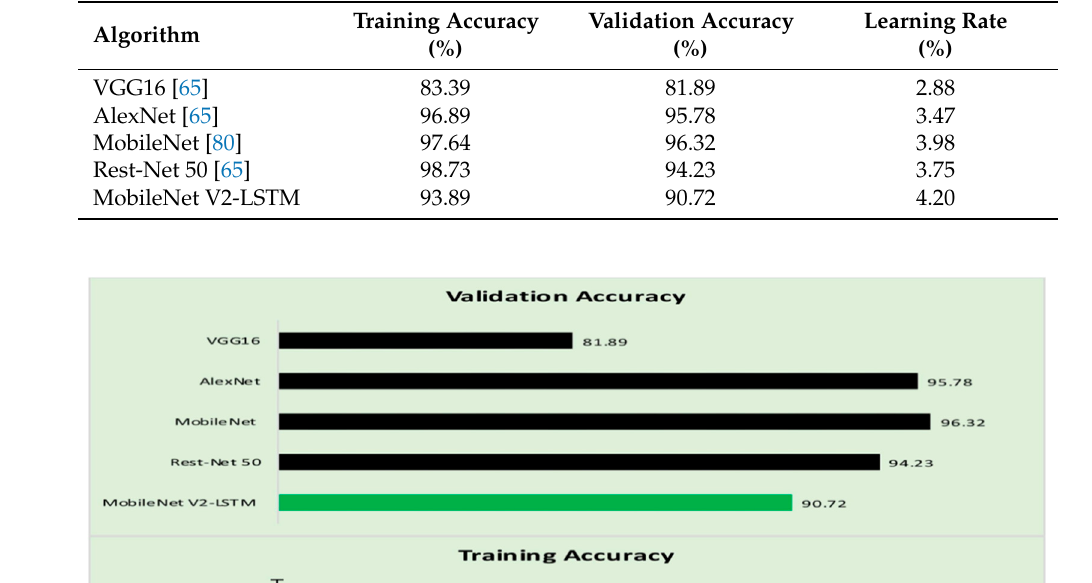
Table 6. The training, validation accuracy, and learning rate.